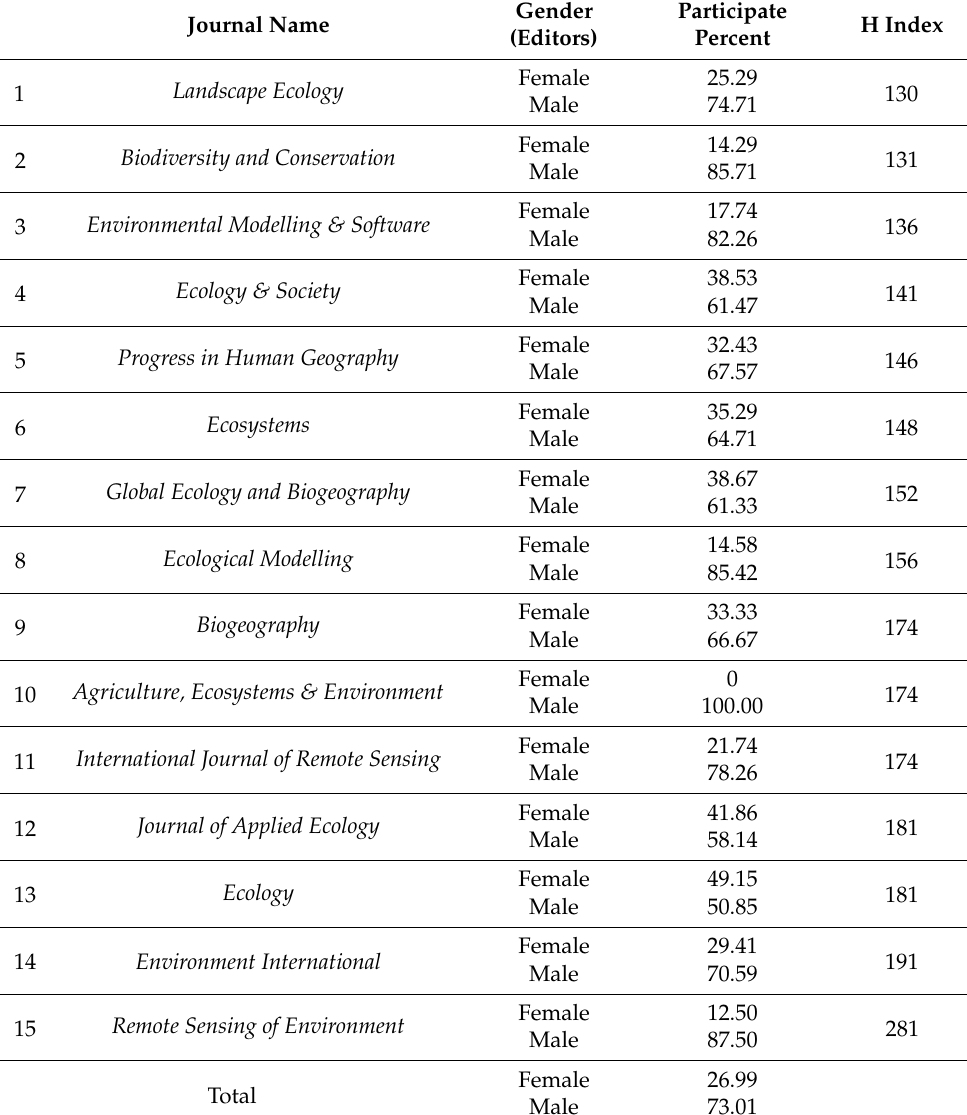
Table 1. Comparing gender contributions in